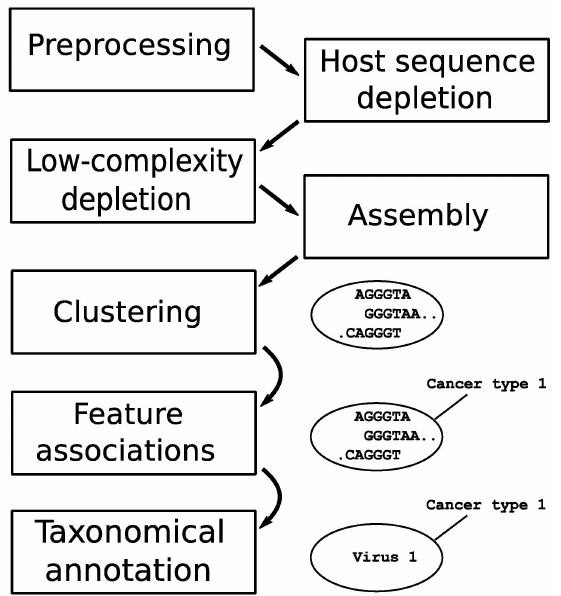
Figure 1. Schematic representation of the bioinformatics pipeline used to process sequencing reads from all data sets. The ‘preprocessing’ step includes removal of adapter sequences, trimming of low-quality sequences, and merging of paired-end reads. Data sets progress in parallel until the ‘clustering’ step, where contigs from all data sets are pooled and